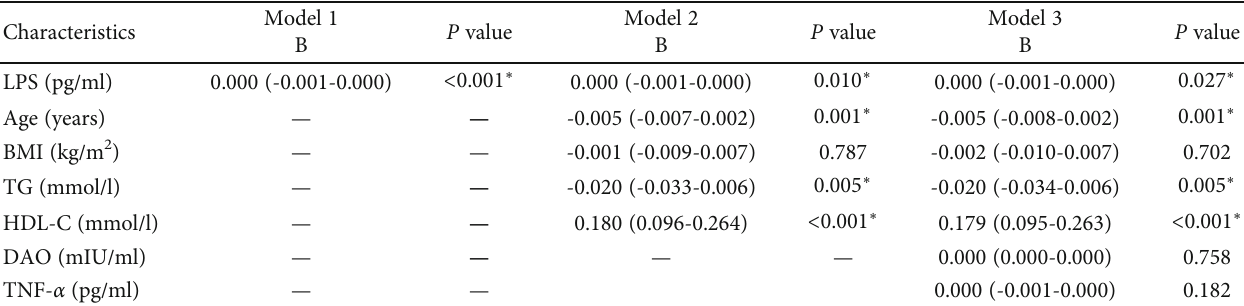
Table 5: Multiple linear regression analysis of the association of Gutt-ISI with LPS. Characteristics